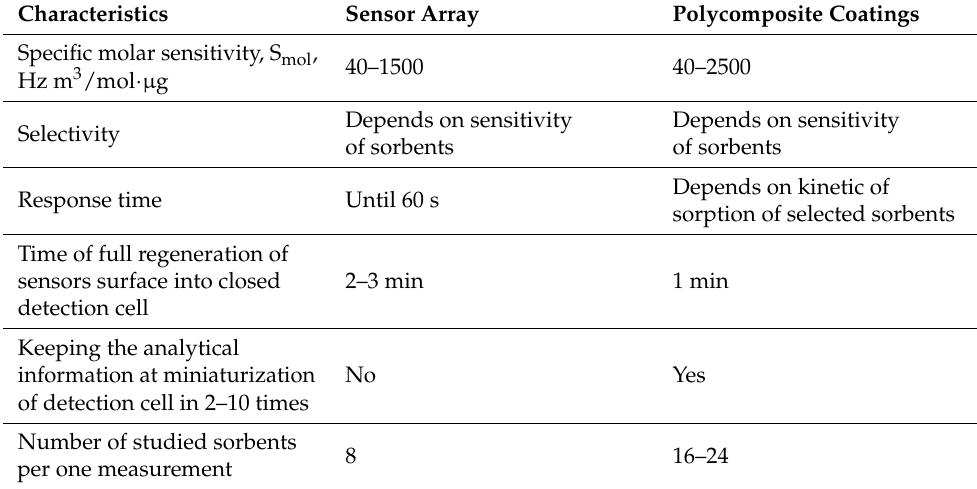
Table 16. Comparison of using sensors array and polycomposite